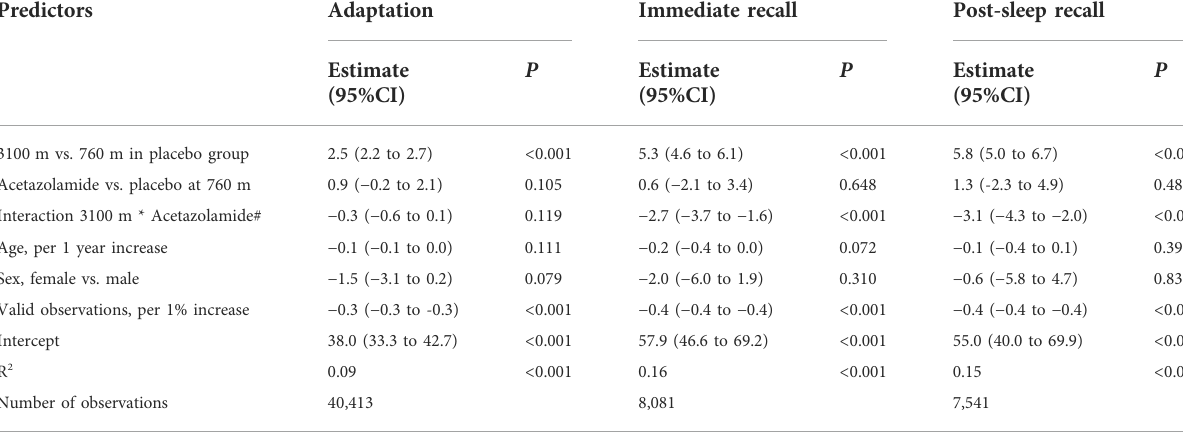
TABLE 2 Effect of altitude exposure, acetazolamide and other predictors on directional error. Predictors